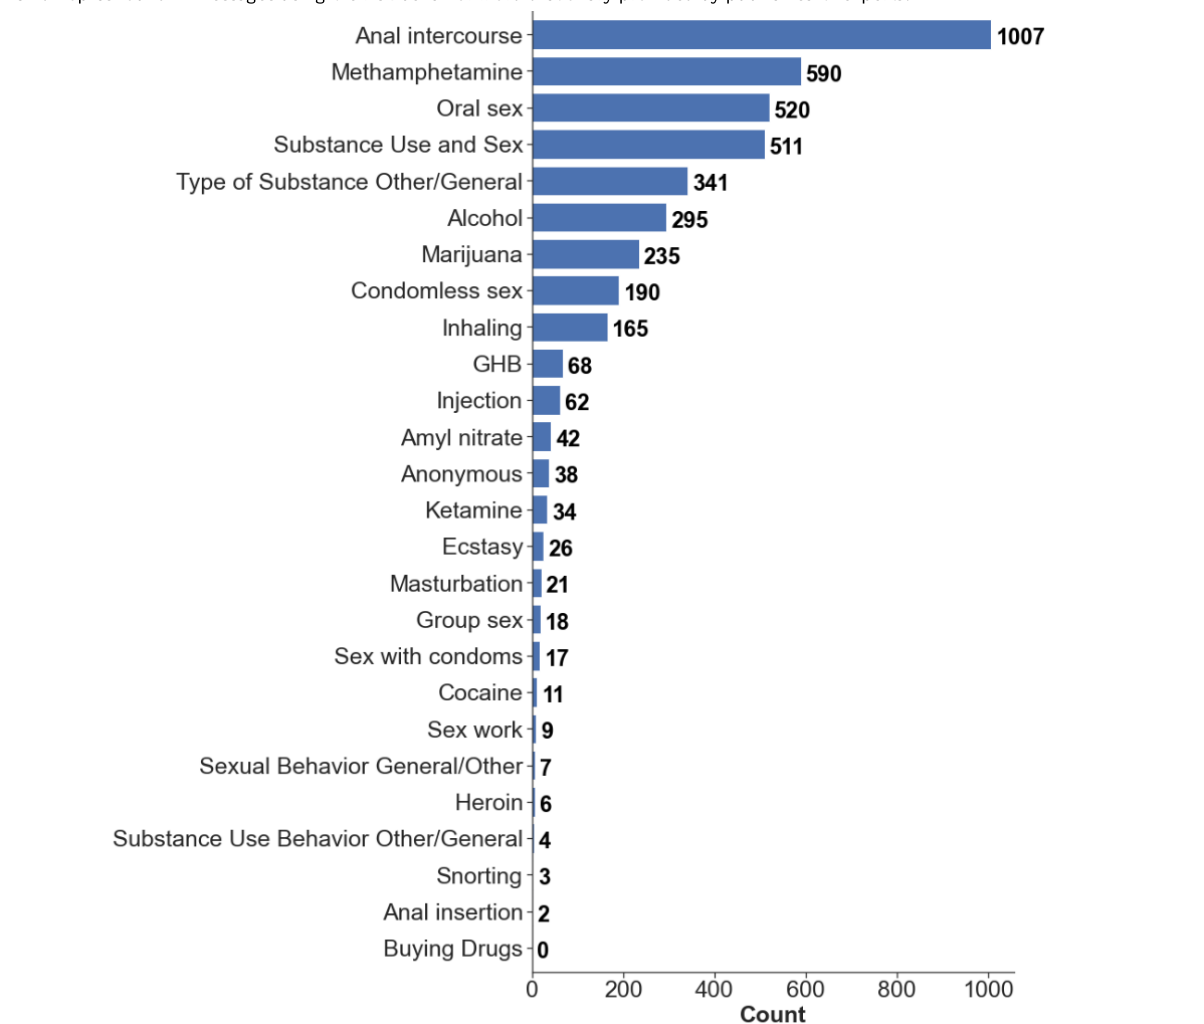
Figure 4. Topics found in messages using the risk behavior word dictionary provided by public health